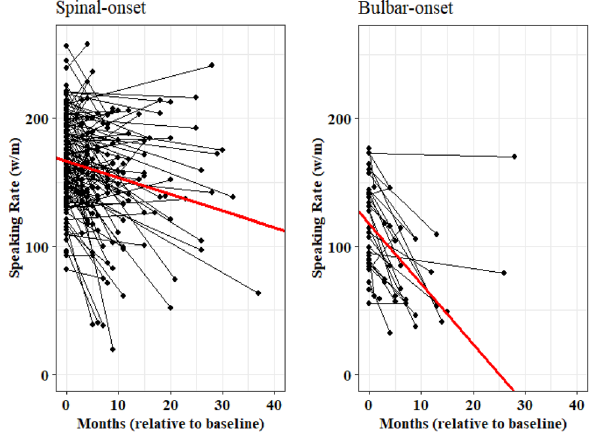
Figure 3. Speaking rate decline (w/m) in individuals with spinal-onset (left plot) and bulbar-onset (right plot) ALS.